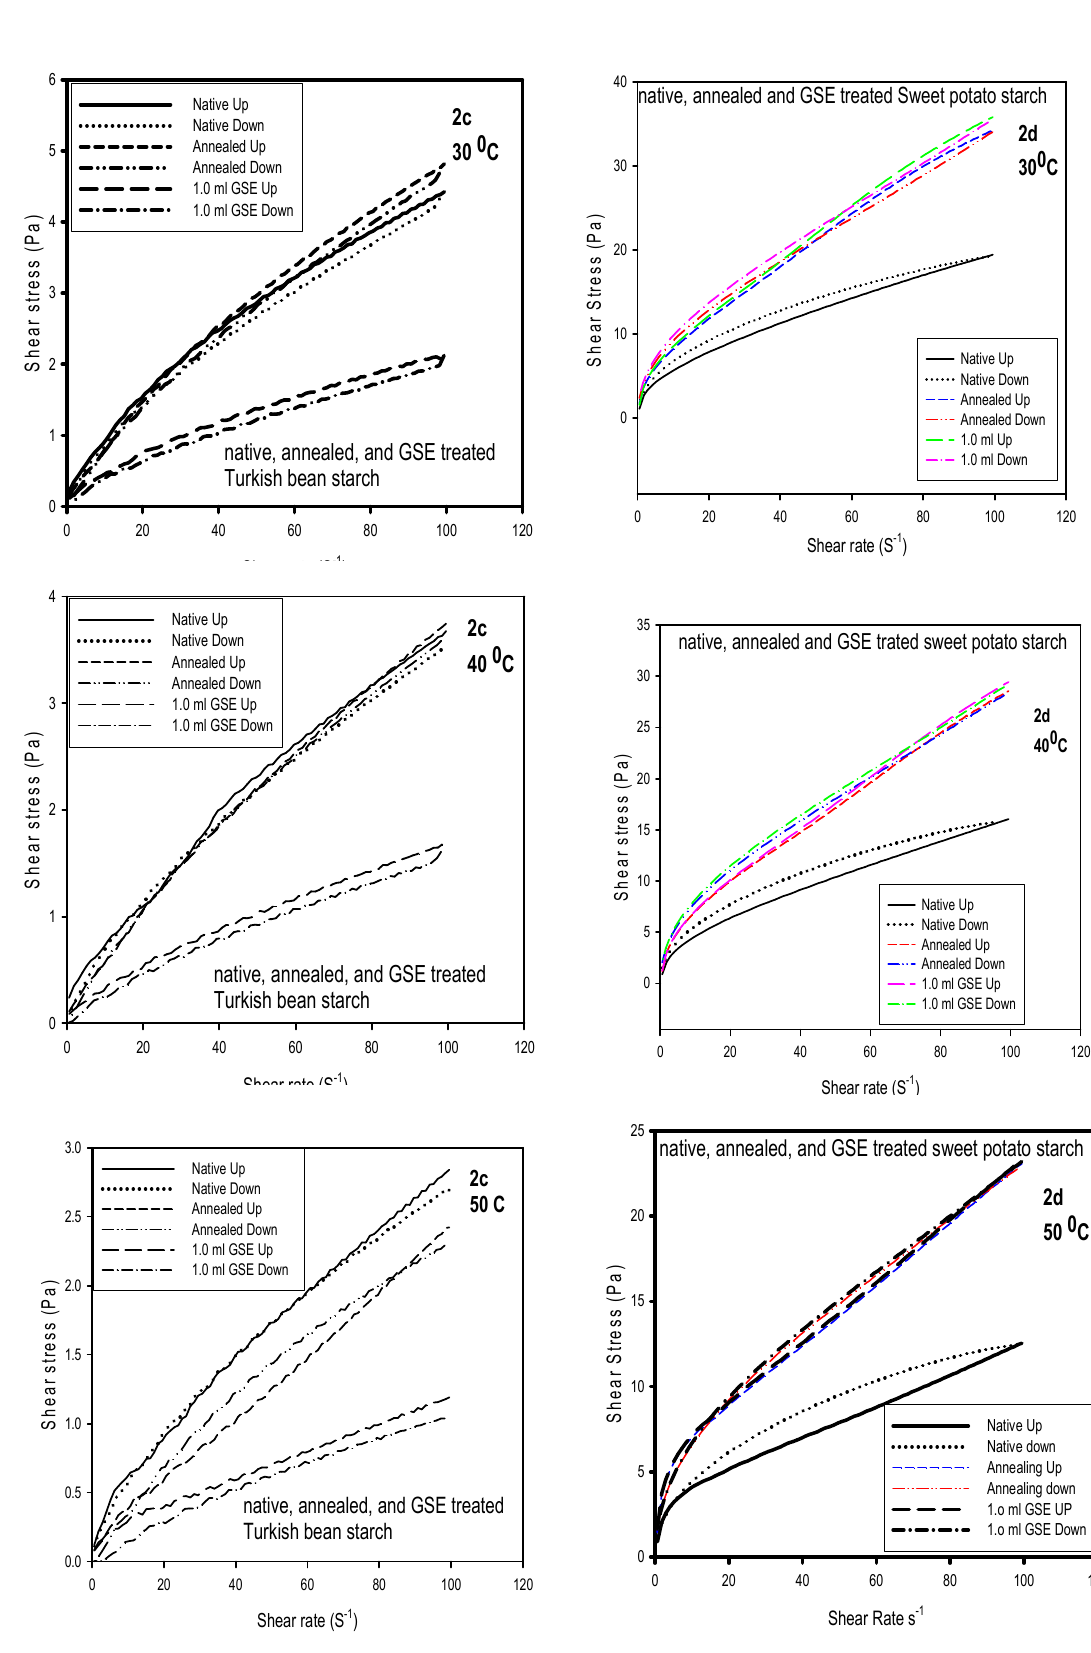
Figure 2. The Herschel-Bulkley model at 30, 40, and 50 ◦ C of chickpea, corn, Turkish bean and sweet potato starches. ( a , b ) The shear rate and shear stress of Herschel-Bulkley model at 30, 40, and 50 ◦ C of chickpea and corn starches; ( c , d ) The shear rate and shear stress of Herschel-Bulkley model at 30, 40, and 50 ◦ C of Turkish bean and sweet potato